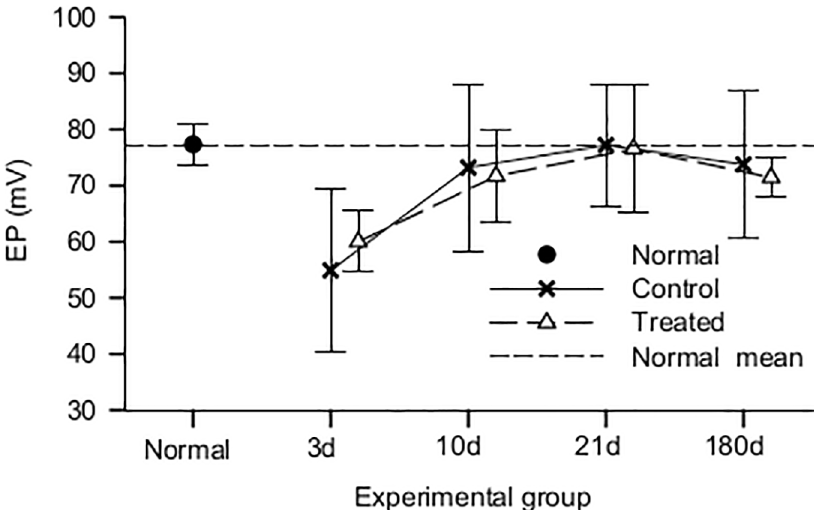
Fig 5. Mean endocochlear potential (EP) values for normal (na ï ve), (-control (noise only)), and treated (noise+HPN-07) groups (n = 6/group). The vertical bars indicatestandard deviationof the data. EP values were significantly decreased in both the control and HPN-07-treated groups at 3d (days) after noise exposure comparedto normalanimals ( p < 0.01) and recovered to the normal level 10d (days) after noise exposure ( p > 0.05). The one-wayANOVA revealed that there were (is) no significantdifferences betweenthe control and HPN-07-treated noise-exposed groups.